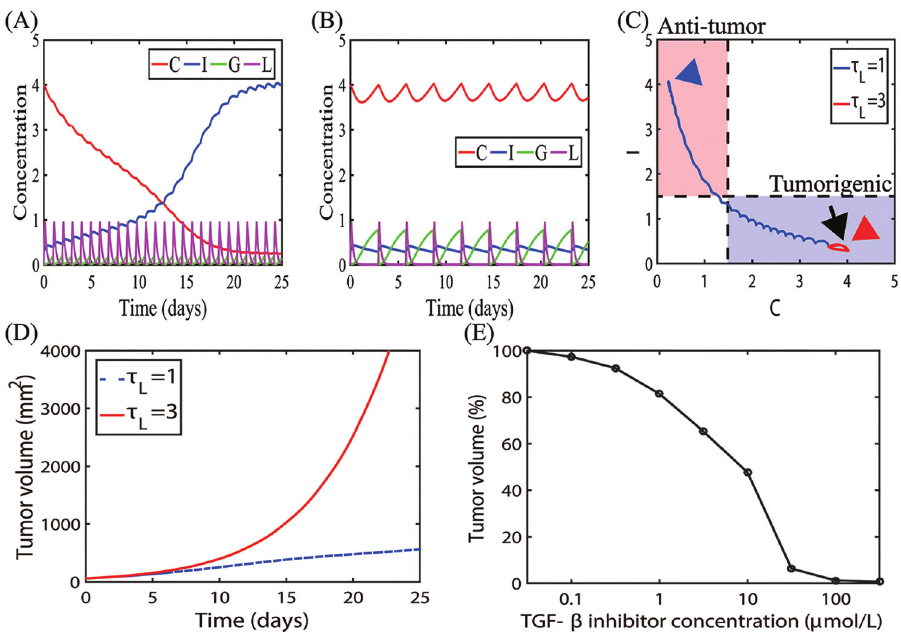
Fig 13. Therapeutic effect of TGF- β inhibitor injection. (A, B) Time courses of activity levels of the N2 complex ( C ) and N1 complex ( I ), and concentrations of TGF- β ( G ) and TGF- β inhibitor ( L ) in response to a periodic injection of the TGF- β inhibitor with periods τ L = 1 (A) and τ L = 3 (B), respectively. (C) Dynamics of the core N1-N2 system in response to the frequent ( τ = 1 in (A)) and less frequent ( τ = 3 in (B)) injections of the TGF- β inhibitor in the C − I L L plane. (D) Time courses of tumor volume for two different injection protocols in (A, B). (E) Tumor volume (%) at final inhibitor. Eqs (8) and (9) then are coupled with the original Eqs (5)–(7) to investigate the effect of TGF- β inhibitors on the transition behaviors between N1 and N2 phenotypes. In Fig 13(A) and 13(B), the dynamic system shows different mode changes as the TGF- β inhibitor was injected at the different periods ( τ = 1, 3). A frequent injection of the inhibitor ( τ = 1 in Fig L L 13A) induces a decrease in the TGF- β level ( G < 0.4), resulting in the transition from the initial tumorigenic condition (black arrow in Fig 13C) to the anti-tumorigenic mode (blue arrow- head in Fig 13C). On the other hand, the TGF- β level still stays in the upper stable branch (Fig 6) in response to a less frequent injection schedule ( τ = 3 in Fig 13B), keeping the system in L the tumorigenic phase (red arrowhead in Fig 13C). These different cellular compositions in N1- or N2-dominant tumor microenvironment result in fast or slow tumor growth: slow and fast tumor growth in response to frequent ( τ = 1) and less frequent ( τ = 3) injection L L schedules, respectively (Fig 13D). Fig 13E shows the normalized tumor volume at final time ( t = 25 days ) for various TGF- β inhibitor levels ( L = 0 − 100 μmol / L ). As the loading dose is 0 decreased, the anti-tumor efficacy is significantly decreased especially when its concentration is less than 10 μmol / L . These results are in good agreement with experimental data [38]. Seri- zawa et al . [38] found that gefitinib, a TGF- β inhibitor, can effectively kill non-small-cell lung cancer cells, PC-9 (cell lines without erlotinib, an EGFR inhibitor) and PC-9ER1/PC-9ER4 (cell lines with resistance to erlotinib) in in vitro experiments [38]. While the overall cell viabil- ities in these cell lines were significantly decreased in response to the increasing concentrations of gefitinib, the anti-tumor efficacy in low dose of gefitinib ( * 0.1 μmol / L ) was higher and sen- sitive in PC-9 cell lines in the response curve. This implies that the higher dose TGF- β